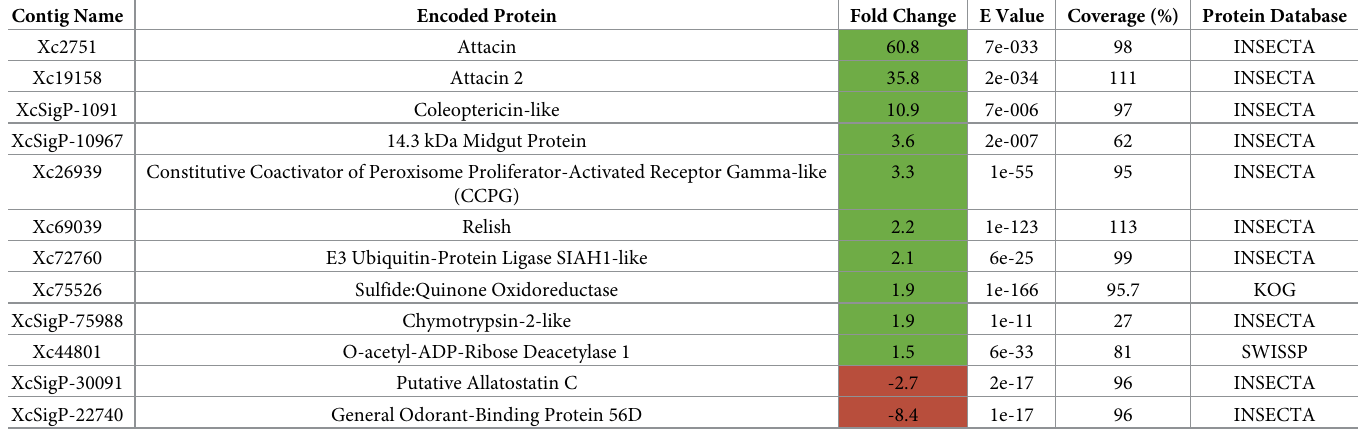
Table 2. Infection-responsive transcripts identified by statistical comparison.